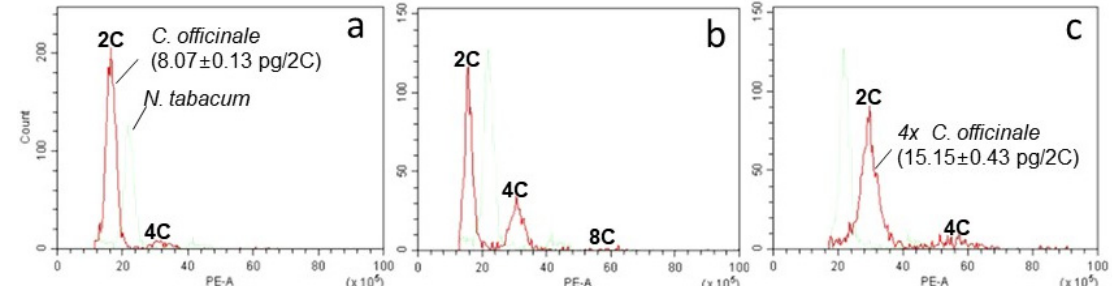
Figure 1. Analysis of the ploidy level of C. officinale plants using flow cytometry. ( a – c ) Histograms showing the DNA content of diploids (control) ( a ), mixoploids ( b ), and tetraploids ( c ). Nicotiana tabacum cv. Xanti (10.07 pg/2C; yellow-green peak) was used as an internal standard.